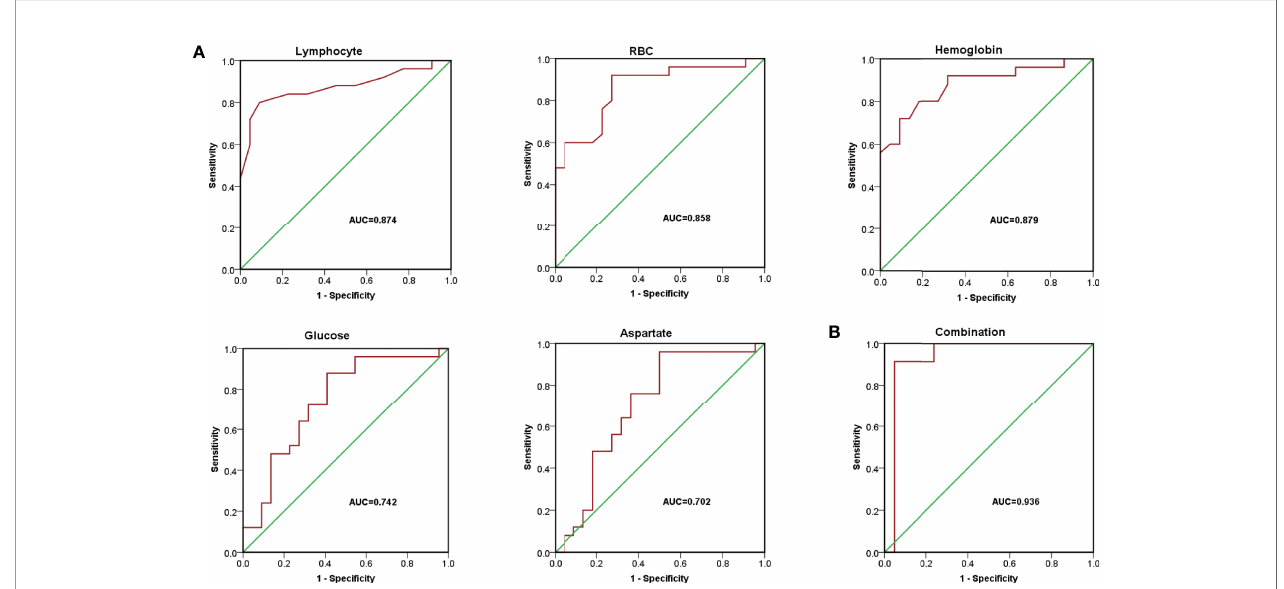
FIGURE 2 | The diagnostic model for DLBCL. (A) Receiver operating characteristic (ROC) curve of lymphocyte, RBC, hemoglobin, glucose, and aspartate with AUC= 0.874, 0.858, 0.879, 0.742, and 0.702, respectively. (B) ROC curves of the combined equation with AUC =